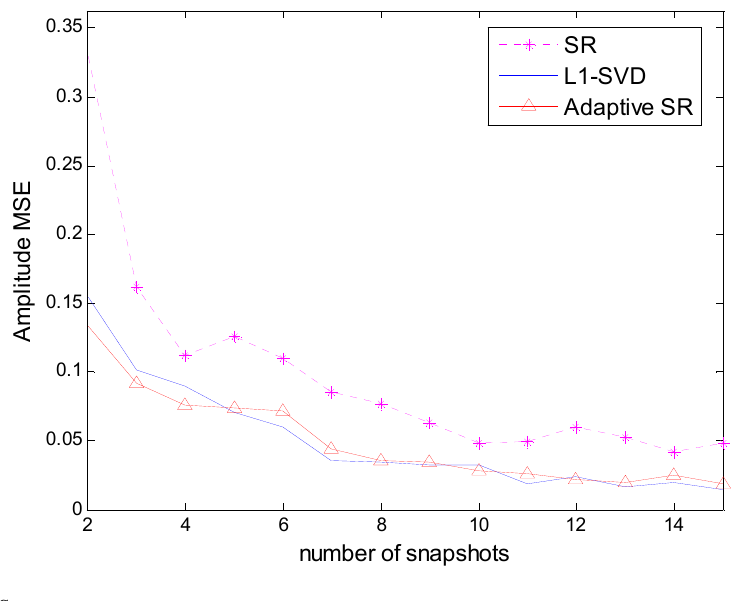
Figure 4. Amplitude MSE against the number of